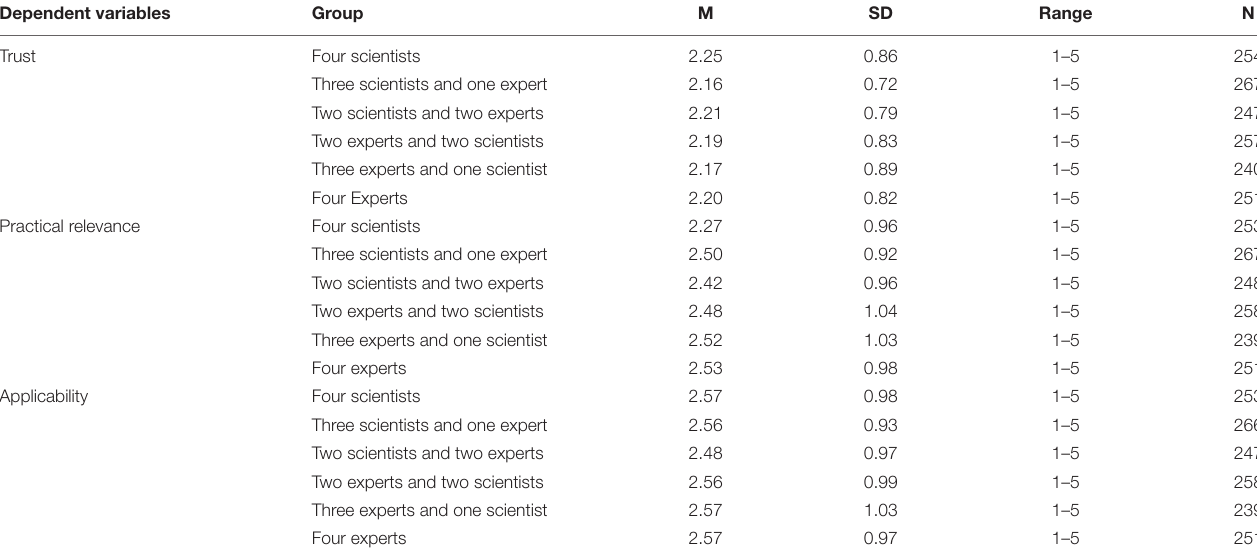
TABLE 2 | Descriptive statistics of dependent variable.